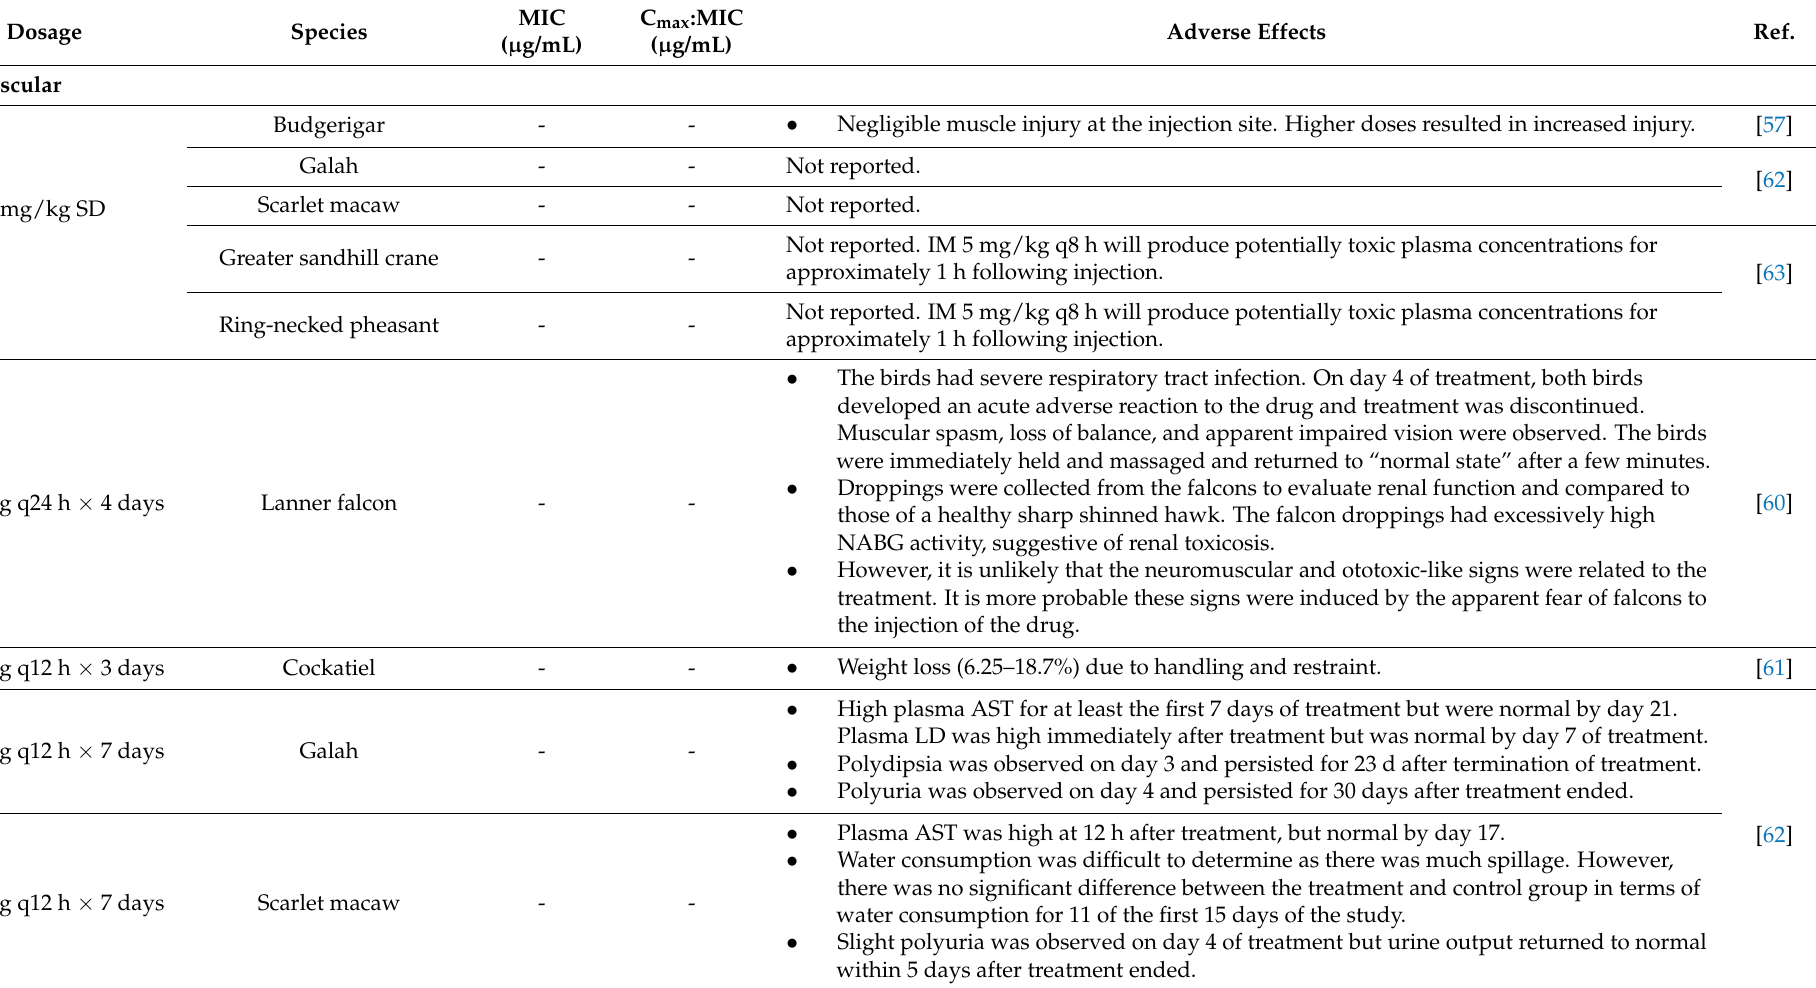
Table 6. Adverse effects and efficacy parameters of gentamicin in exotic avian